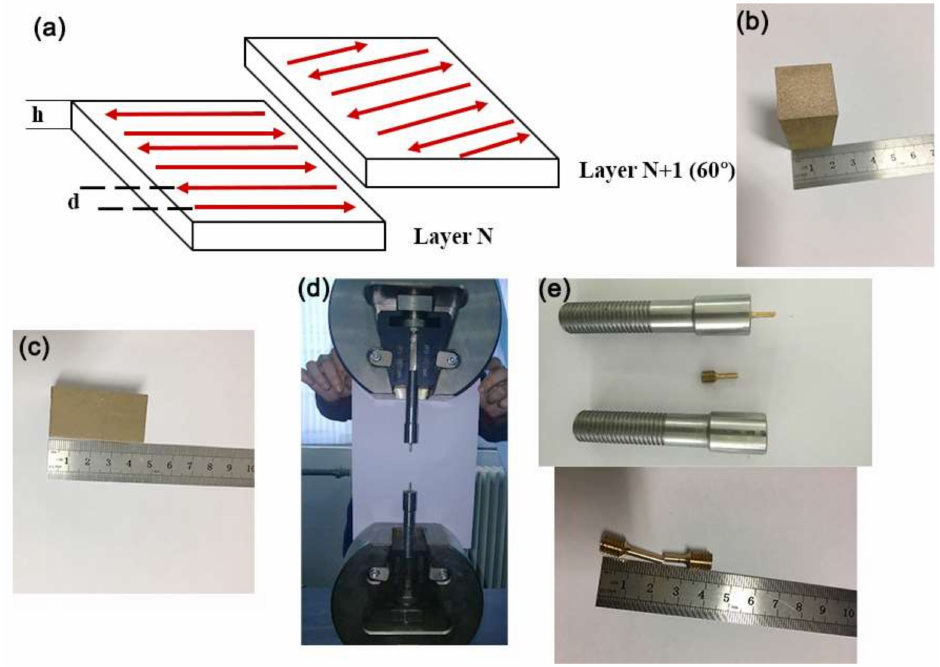
Figure 1. Three-dimensional (3D)-printed samples and room temperature tensile tests. ( a ) The fabrication process; ( b ) The width of three-dimensional (3D)-printed sample; ( c ) The length of three-dimensional (3D)-printed sample; ( d ) Tensile specimen machine; ( e ) The sample used for tensile